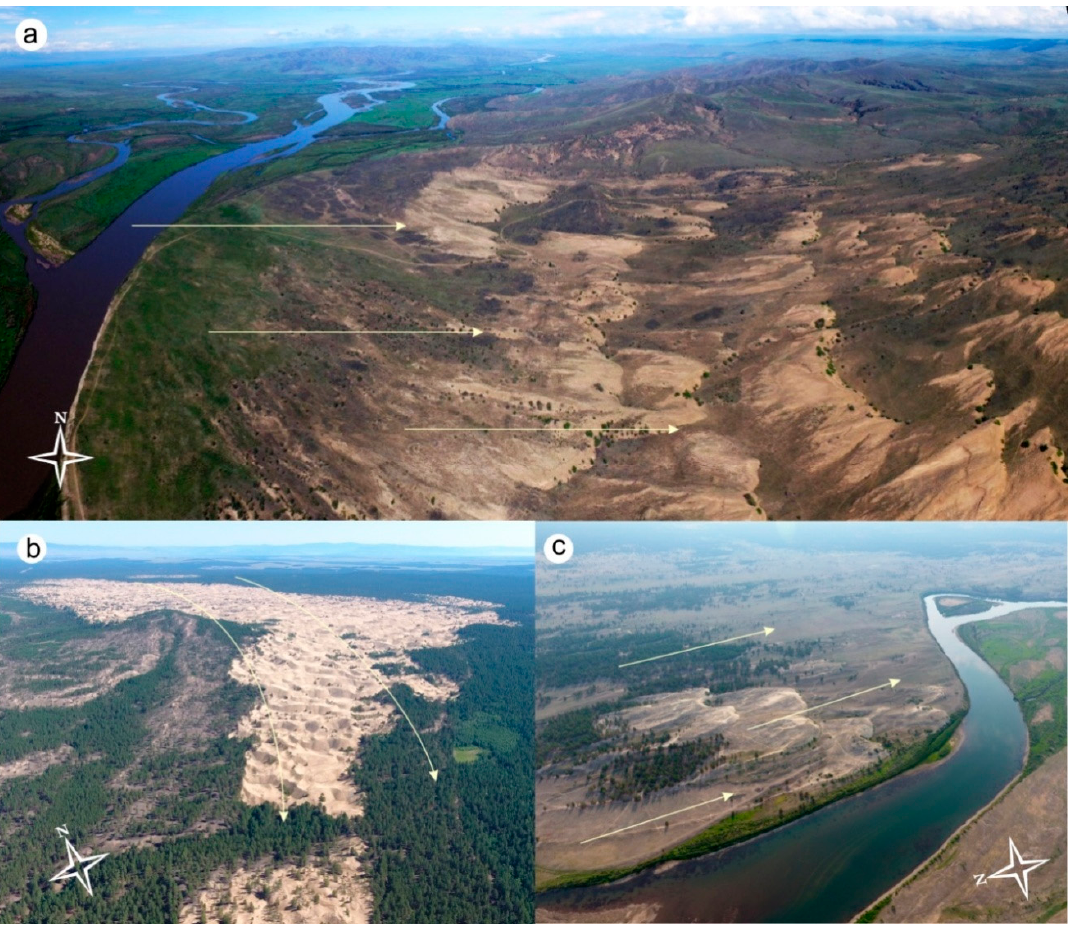
Figure 4. Drift aeolian sands of the Selenginskii middle mountains: ( a )—Nomokhonovo stow (photo by S. Makarov, 2018); ( b )—Mankhan-Elysu sandy massif (2017); ( c )—dunes at the mouth of the Chikoi river (2017) (arrows indicate the direction of the main air flow).